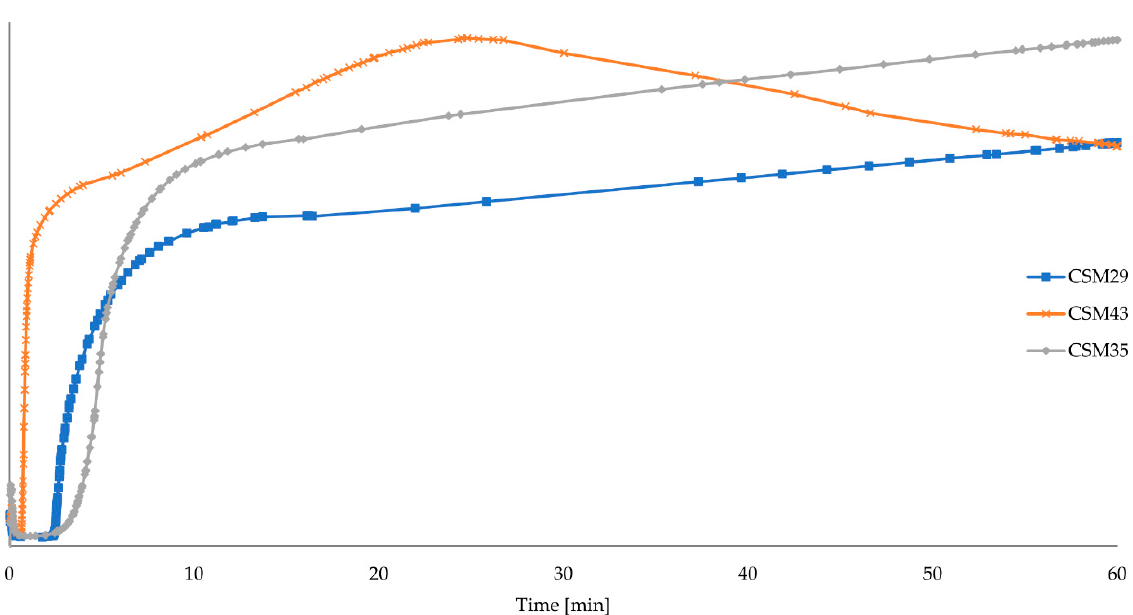
Table 3. Values of equilibrium swelling of unfilled CSM vulcanizates; T = 160 °C, t = 15 min.